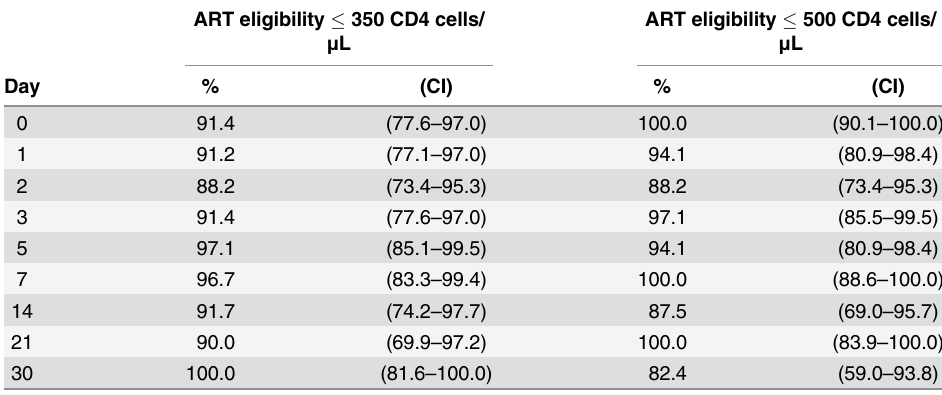
Table 2. Percentage of correctly classified BD Vacutainer CD4 Stabilization Tube sample results on BD FacsCount for ART eligibility thresholds of 350 and 500 CD4 cells/ μ L over time with EDTA tube results on FacsCount at day 0 as reference